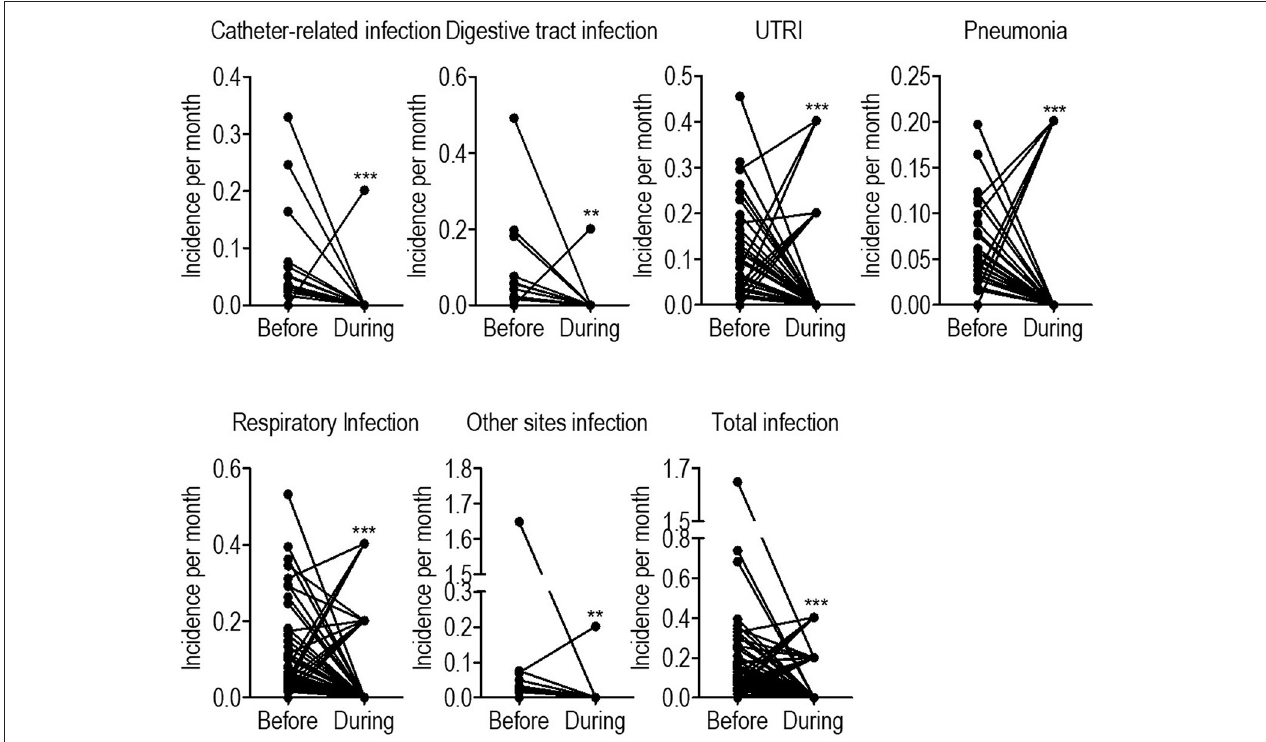
FIGURE 3 | Historical paired comparison on infectious episodes before and during the COVID-19 pandemic. URTI, upper respiratory tract infection. * p < 0.05; ** p < 0.01; **** p < 0.001.